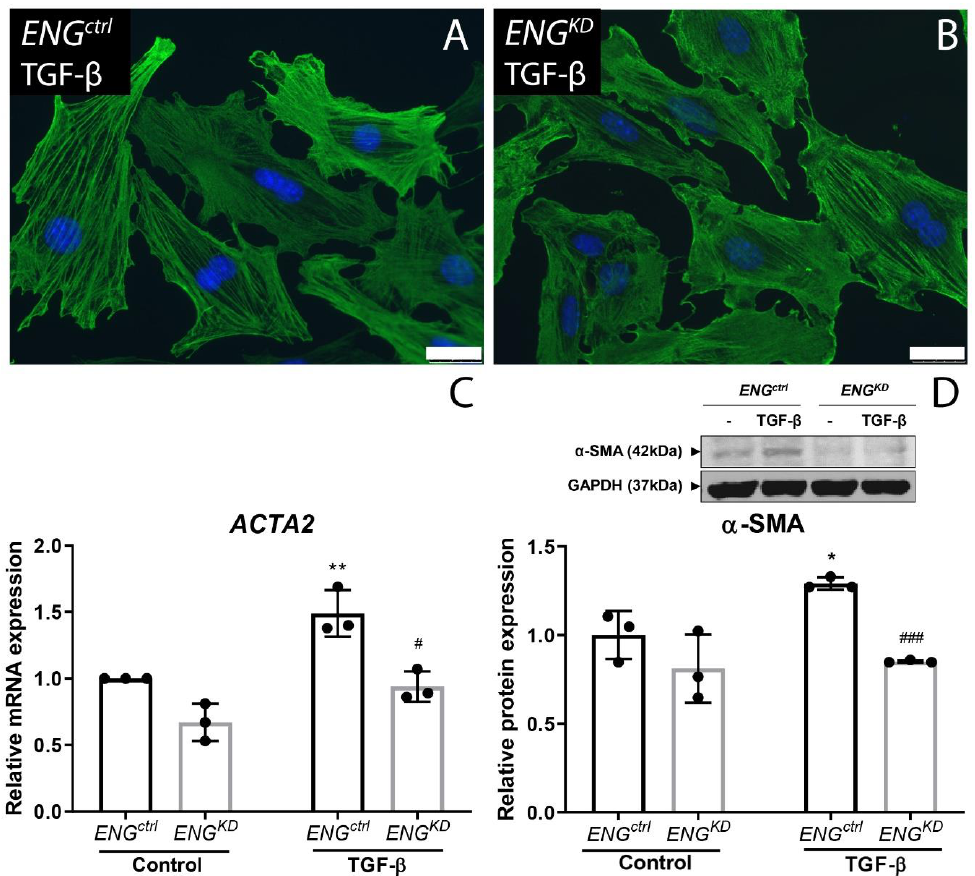
Figure 5. TGF-β-induced upregulation of the myofibroblast differentiation marker α-SMA is